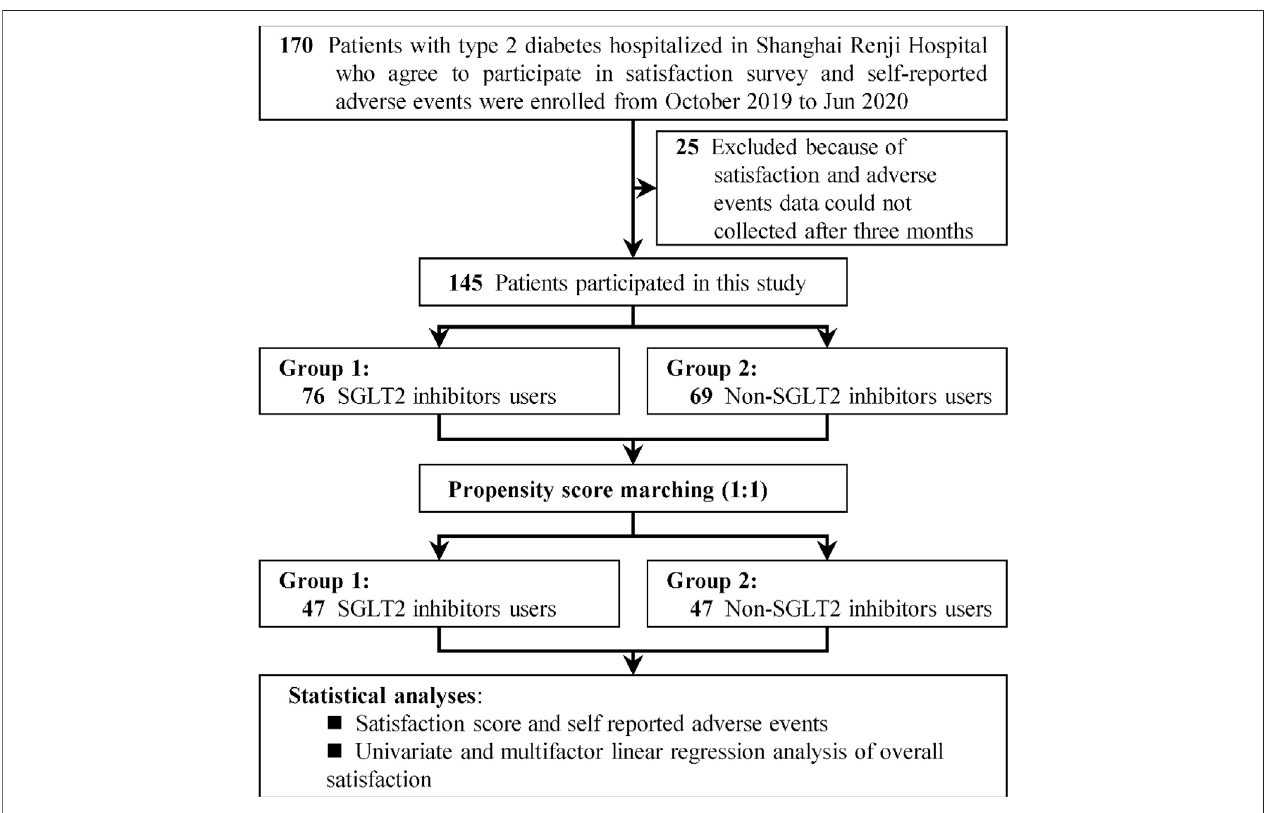
FIGURE 1 | The study follow diagram. Abbreviation: SGLT2: sodium-glucose co-transporter 2.